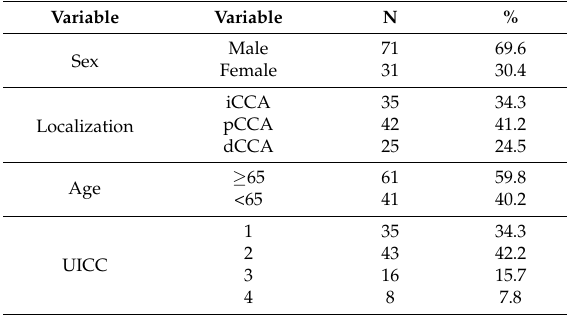
Table 1. Clinicopathological characteristics of the patient